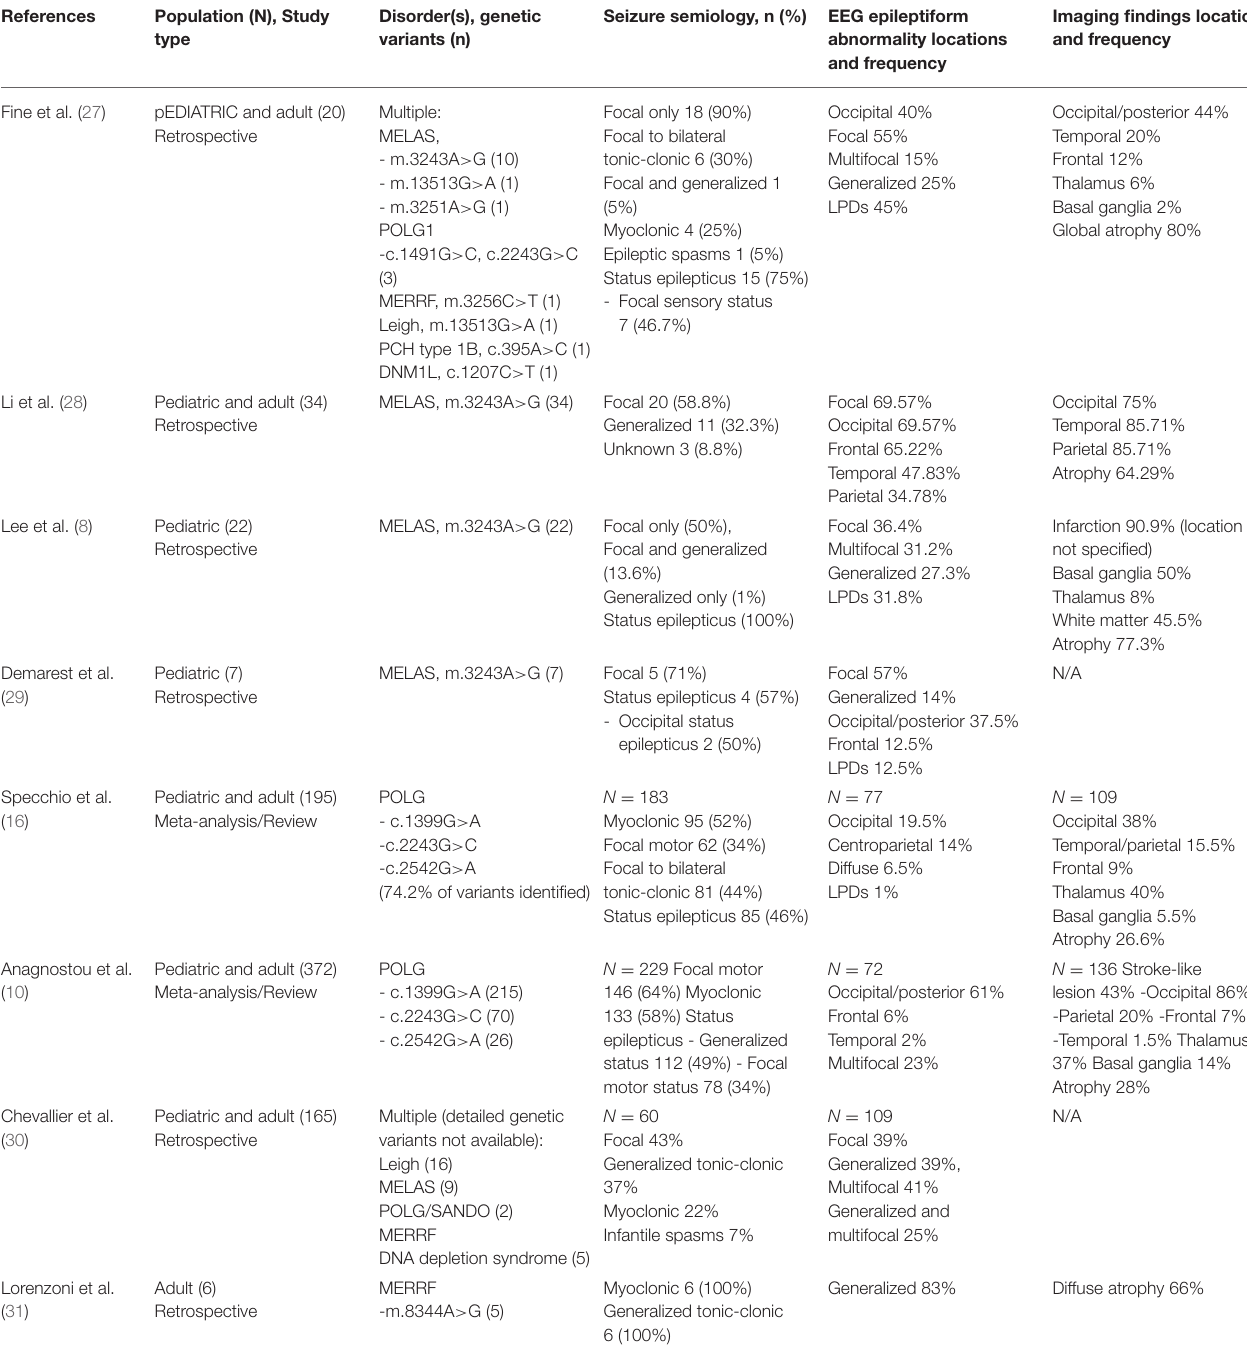
TABLE 3 | Review of selected studies on epilepsy in patients with mitochondrial